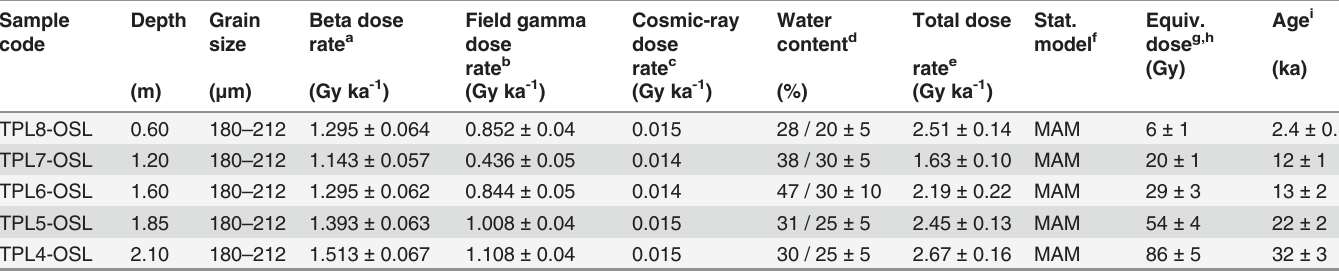
Table 1. OSL single-grain dating of sediments from Tam Pa Ling: dose rate data, equivalent doses and ages. Sample Depth Grain code